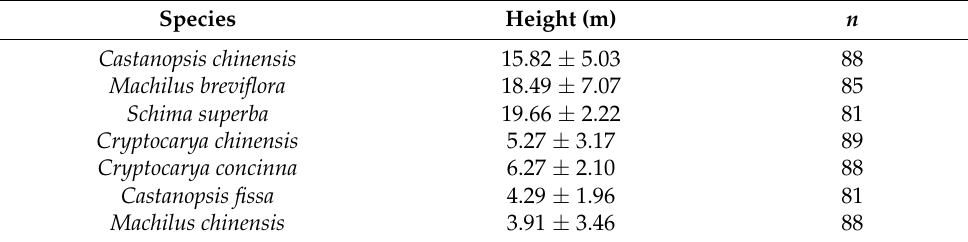
Table A2. Tree height and sample number of the seven target species.